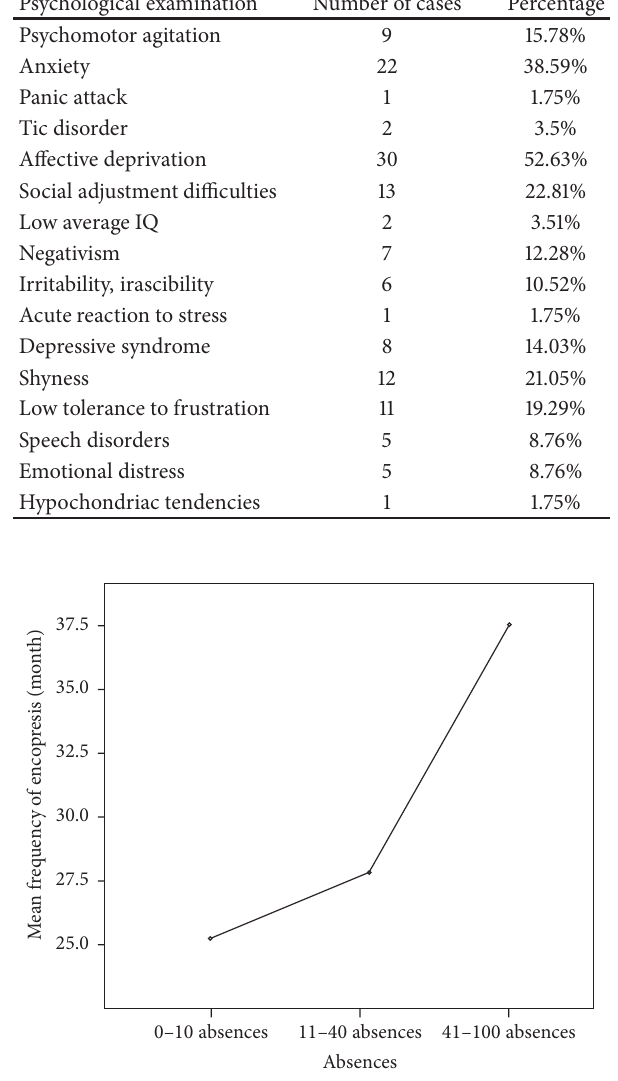
Figure 3: The average value of encopretic episodes’ frequencies compared to the number of missed